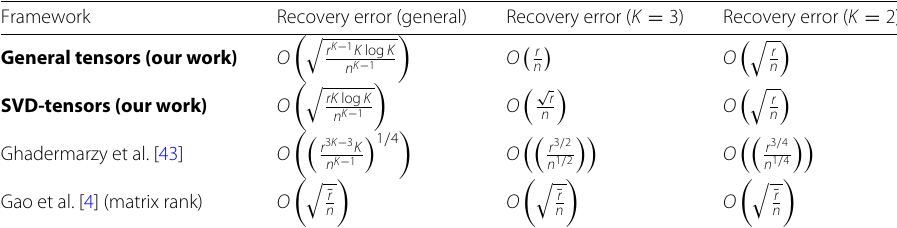
Table 1 Comparison of our method to state-of-the-art quantized matrix recovery method and 1-bit tensor recovery